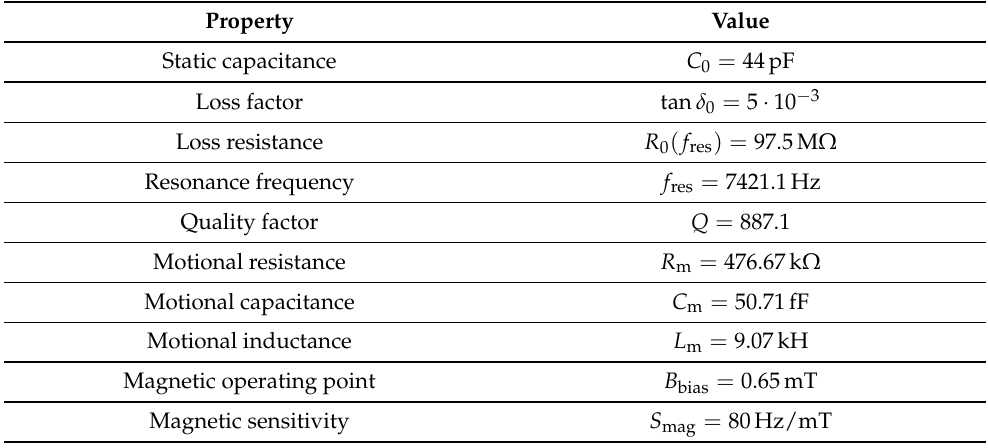
Table 1. Electromechanical and magnetic properties of the exemplary magnetic field sensor referred to in this